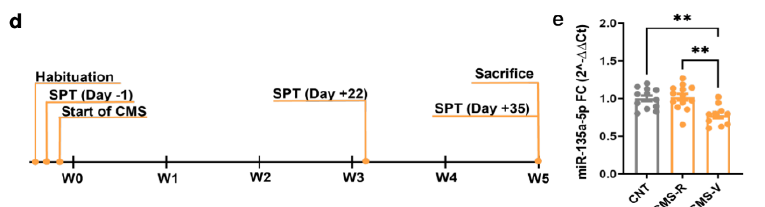
Figure 1. Changes of miR-135a-5p expression in the PFC of FS and CMS rats. ( a ) Experimental plan timeline of FS. Rats were subjected to a single session of FS and sacrificed immediately after 40 min or after 24 h. ( b ) miR-135a-5p expression levels measured by qPCR in the PFC of rats sacrificed immediately after stress. Mann – Whitney test, ** p < 0.01; N = 6 (CNT), 7 (FS). ( c ) miR-135a-5p expression levels measured by qPCR in the PFC of rats sacrificed 24 h after the beginning of stress. Student’s t -test, *** p < 0.001; N = 8 (CNT), 8 (FS). ( d ) Experimental plan timeline of CMS. Rats were subjected to 5 weeks of CMS and sacrificed after the last SPT on Day 35. ( e ) miR-135a-5p expression levels measured by qPCR in the PFC of rats. One-way ANOVA F = 2.374 (2, 23 ), Tukey’s post hoc test, ** p < 0.01; N = 12 (CNT), 13 (CMS-R), 10 (CMS-V).